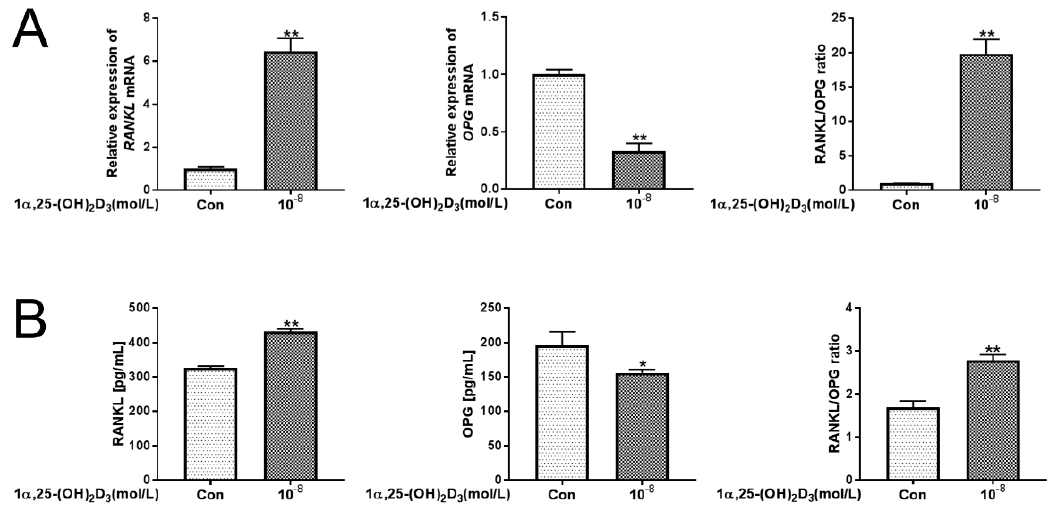
Figure 3. Application of 10 − 8 mol/L 1 α ,25(OH) 2 D 3 upregulates the RANKL/OPG ratio in BMSCs. ( A ) BMSCs were seeded in 6-well plates with or without (Con) 1 α ,25(OH) 2 D 3 . After 5 d, qRT-PCR was used to quantitate the expression of RANKL and OPG mRNA, and the RANKL/OPG ratio was calculated. ( B ) BMSCs were seeded in 6-well plates with or without (Con) 1 α ,25(OH) 2 D 3 . After 5 d, the cell supernatant was collected, and ELISA kits were used to measure RANKL and OPG protein levels. (Graph bars show mean ± SD. * p < 0.05 and ** p < 0.01 show significant difference compared with the control group; n = 3 per group.).